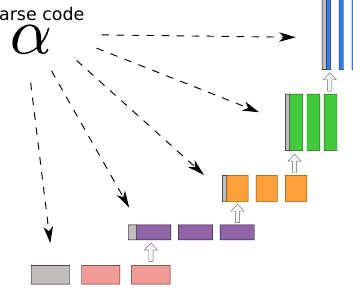
Figure A5. Architecture of the ISTA U-Net adapted from [42]. The sparse code α replaces the downsampling part in the standard U-Net (cf. Figure